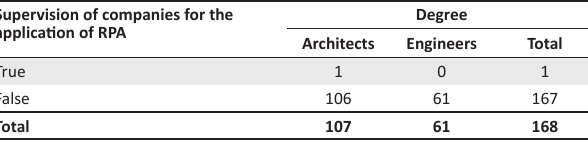
Table 17: Guidance of companies for the application of Algerian paraseismic rules. Supervision of companies for the application of